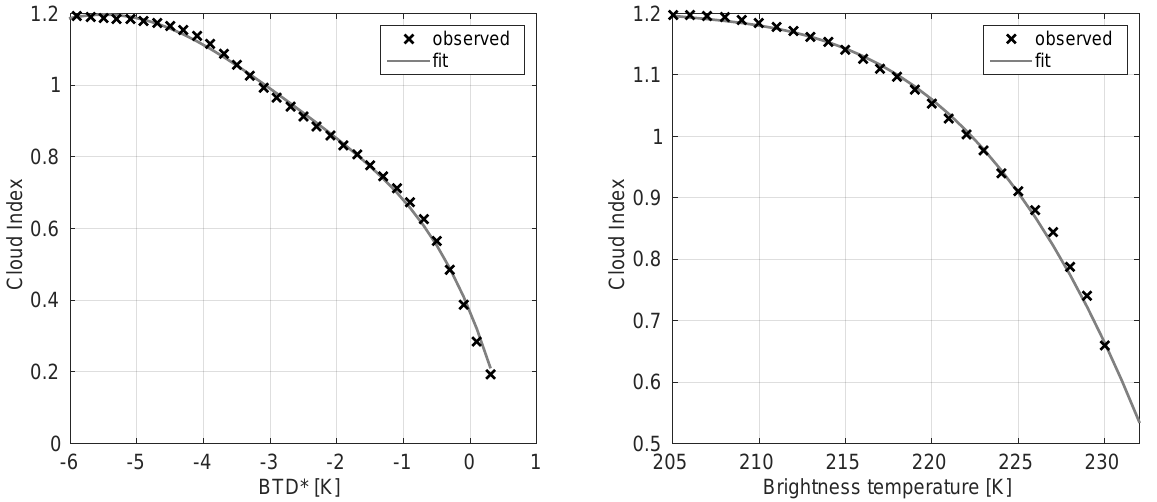
Figure 6. ( left ) Relation f index for fog and low stratus. ( right ) Relation f cloud index for very cold clouds T